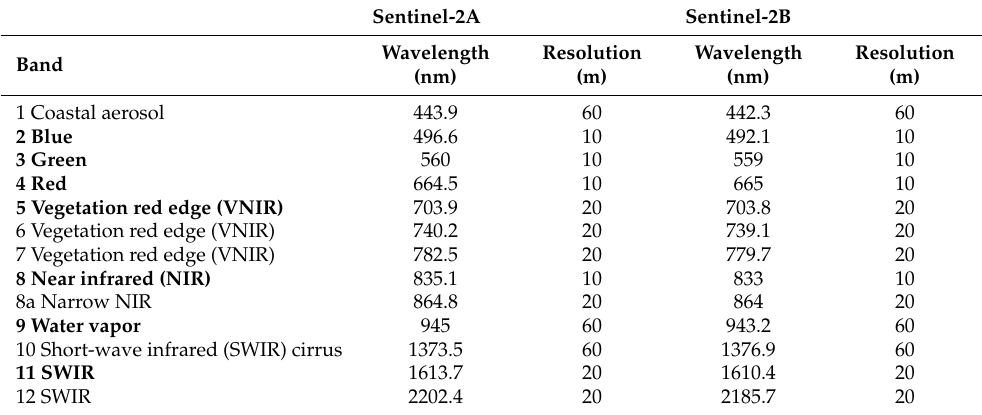
Table 1. Spectral bands for Sentinel-2A and Sentinel-2B sensors. Bold bands were used in this